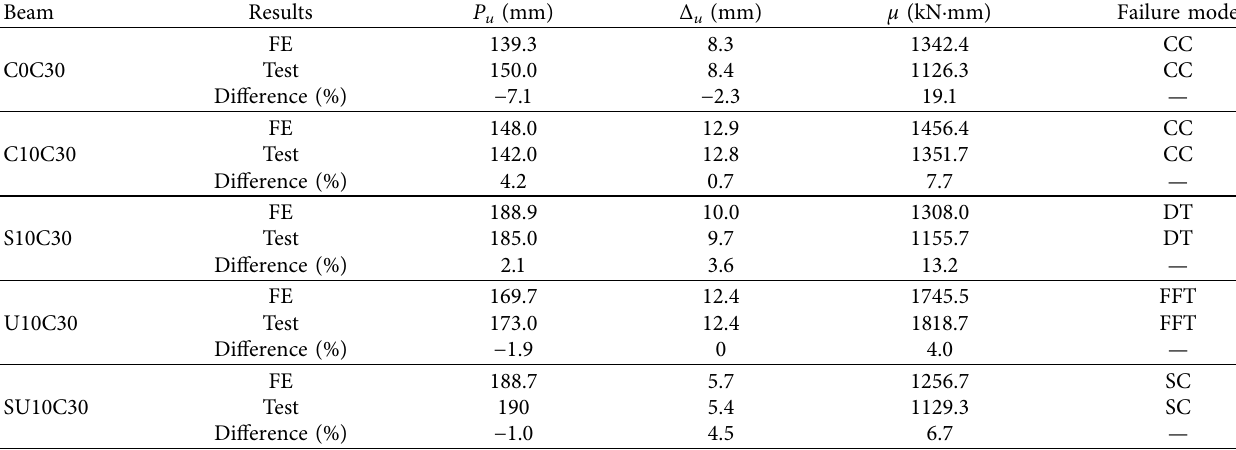
Table 3: Validation results between the test and FE